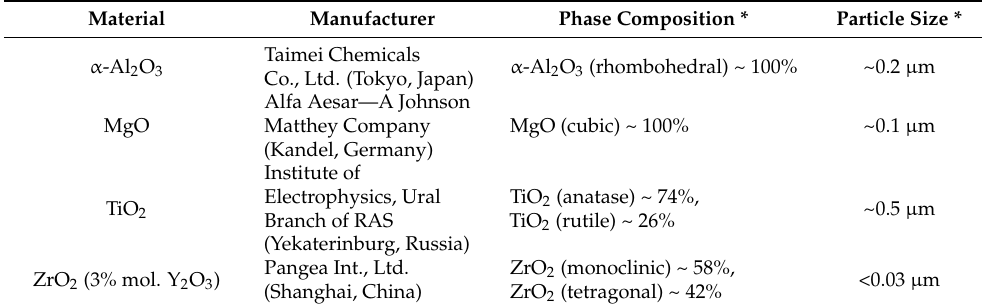
Table 1. Description of the starting